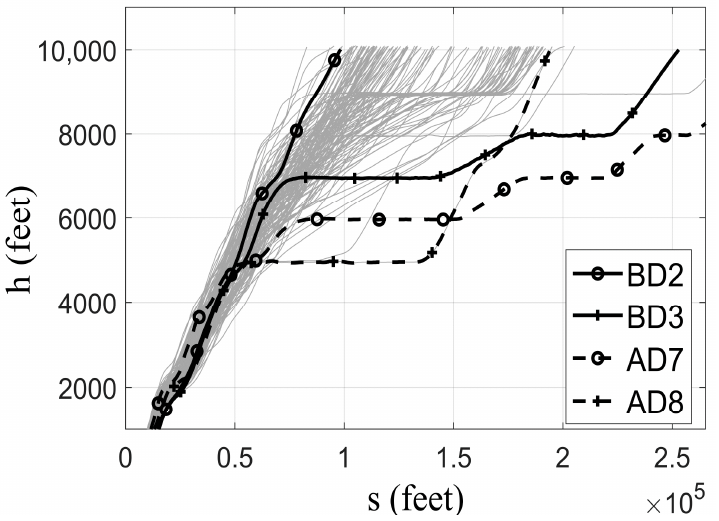
Figure 25. Flight profiles of B777 and A330 aircraft departing from HKIA (grey curves), with two pairs of flights selected (namely, BD2 and BD3, AD7 and AD8).